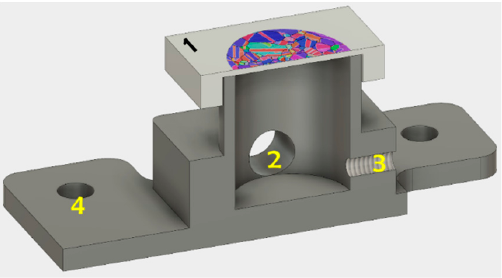
Figure 1: Cross section of specimen and electrochemical cell. 1) Nickel specimen, 2) electrolyte in-/output, 3) screw as counter electrode 4) holes for fixation in the